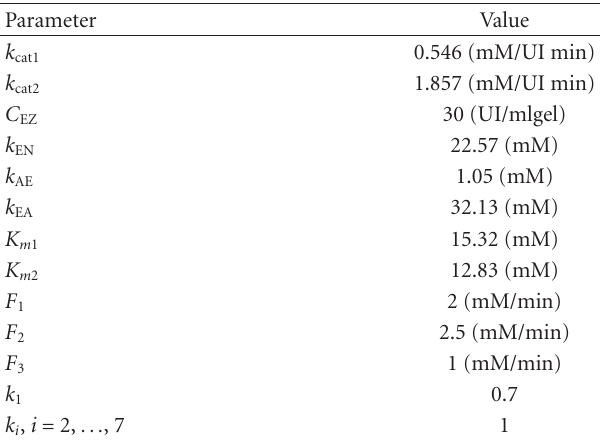
Table 1: Bioprocess parameters